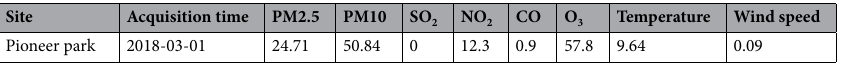
Table 4. Acquisition data